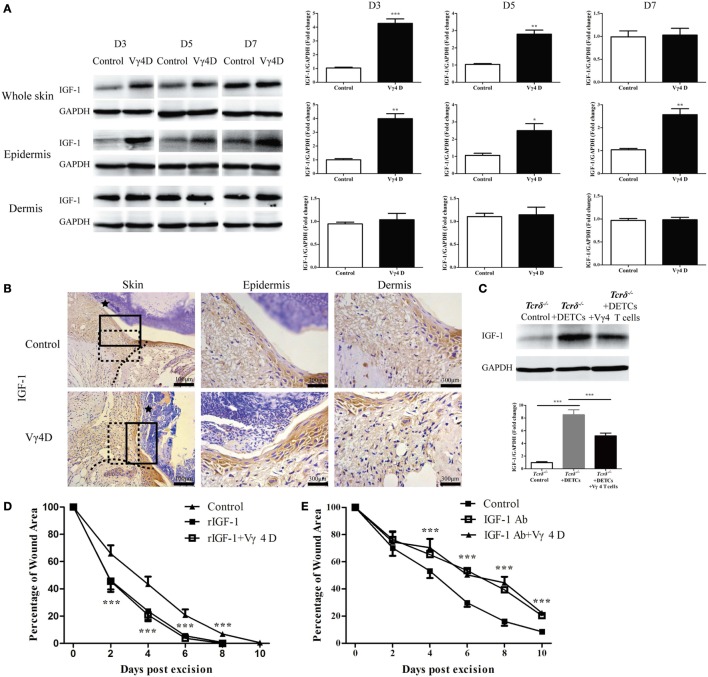
Vγ4 T cells inhibited epidermal IGF-1 production to delay skin wound repair. (A,B) Full-thickness wounds were generated in Vγ4 T-cell depletion (Vγ4D) and control mice. On day 3, 5, and 7 post-wounding, each group of epidermis tissues at wound margins was collected from at least three mice for further analysis of IGF-1 production by means of WB (A) and IHC (B). The area of wound and neo-epidermis is marked by black star (Skin). Neo-epidermis in solid rectangles and neo-dermis in dashed rectangles were amplified threefolds and labeled as Epidermis and Dermis (B). (C) Fresh isolated dendritic epidermal T cells (DETCs) (5 × 104 cells/wound), DETCs (5 × 104 cells/wound) plus Vγ4 T cells (1 × 104 cells/wound), or PBS were added onto wound bed of Tcrδ−/− mice (n = 5/group) immediately after skin injury, respectively. IGF-1 expression in epidermal wound margin was detected by WB on day 3 post-wounding. (D,E) Age- and sex-matched C57BL/6 wild-type mice were intraperitoneally injected with Vγ4D Ab UC3, or isotype control Ab (Control) on day −3. Followed by administration of 200 ng/wound rIGF-1 (D) or 20 μg/wound IGF-1 neutralizing Ab (E) onto wound margin on days 0, 1, and 2 post excision. Control mice in (E) were treated with IGF neutralizing isotype Ab (poly goat IgG). Wound-closure kinetics was measured over time and dots in wound closure kinetics represent 10 wounds (2 wounds/mouse, 5 mice/group). Star-like markers represent the differences between rIGF-1 + Vγ4D and Control in (D), IGF-1 Ab + Vγ4D and Control in (E). Data are representative of at least three independent experiments with cohorts of the indicated number of mice per group. Bars show mean ± SD. P value was calculated by Student’s unpaired t-test (A,D,E) or one-way ANOVA with Bonferroni’s multiple comparison test (C) (***P < 0.001).